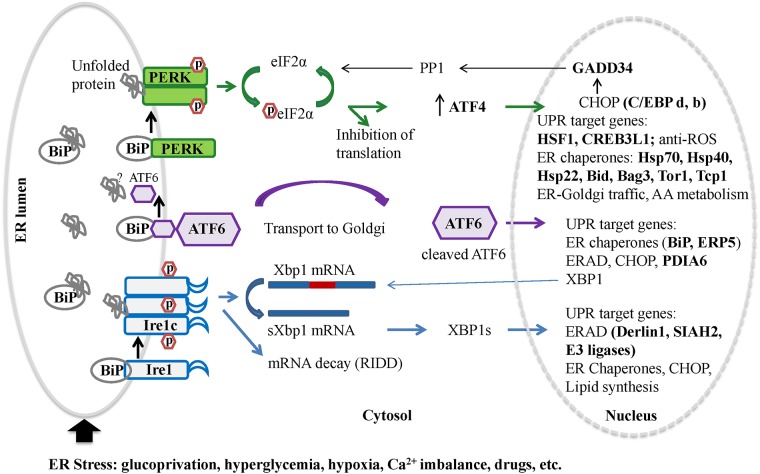
RH induces the unfolded protein response in rat adrenal medulla.A schematic of the unfolded protein response in mammals is presented. In resting cells all three ER stress sensors are inactive due to association with Grp78. Accumulation of unfolded proteins leads to dissociation of Grp78 and activation of IRE1, ATF6 and PERK which reprogram transcription and translation in a concerted manner to restore homeostasis: increase the transcription of genes involved in protein folding (ATF6 and IRE1 signaling), attenuate global protein synthesis (PERK) by phosphorylating translation initiation factor 2 (eIF2a) while promoting the translation of ATF4. ATF4 controls the expression of CHOP, which in turn induces GADD34 –a negative feedback loop effector that terminates UPR signaling by recruiting protein phosphatase1 catalytic subunit resulting in dephosphorylation of eIF2a and recovery of protein synthesis ([37]). Selected genes affected only by RH in our experiments are indicated in bold.